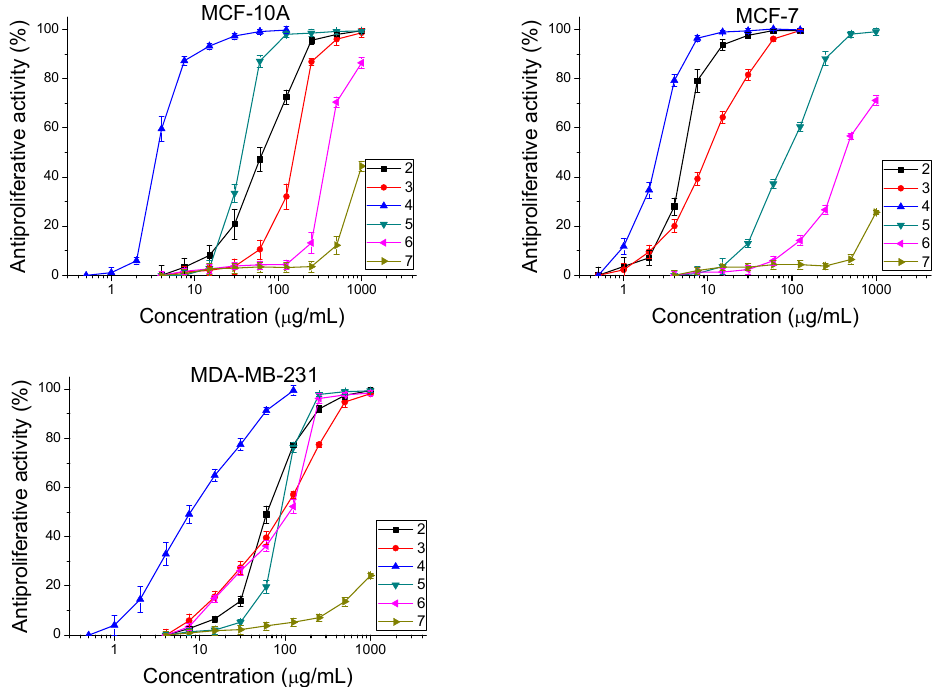
Figure 6. Antiproliferative activities of compounds 2 – 7 expressed in % relative to the negative con- trol.